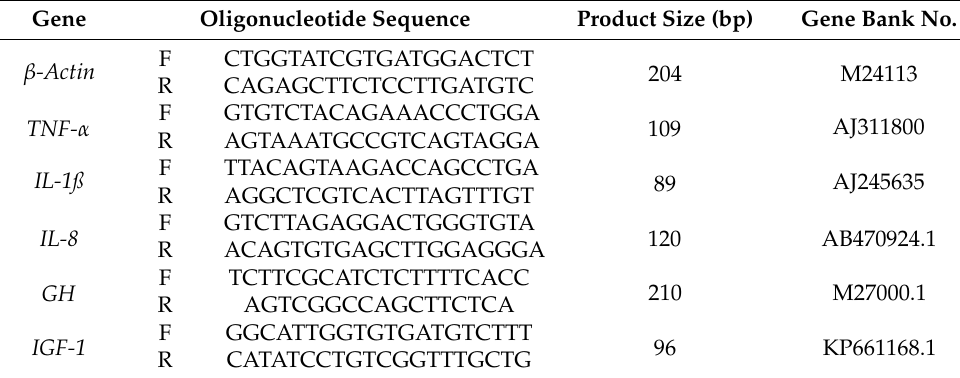
Table 3. Primer sequences used in this